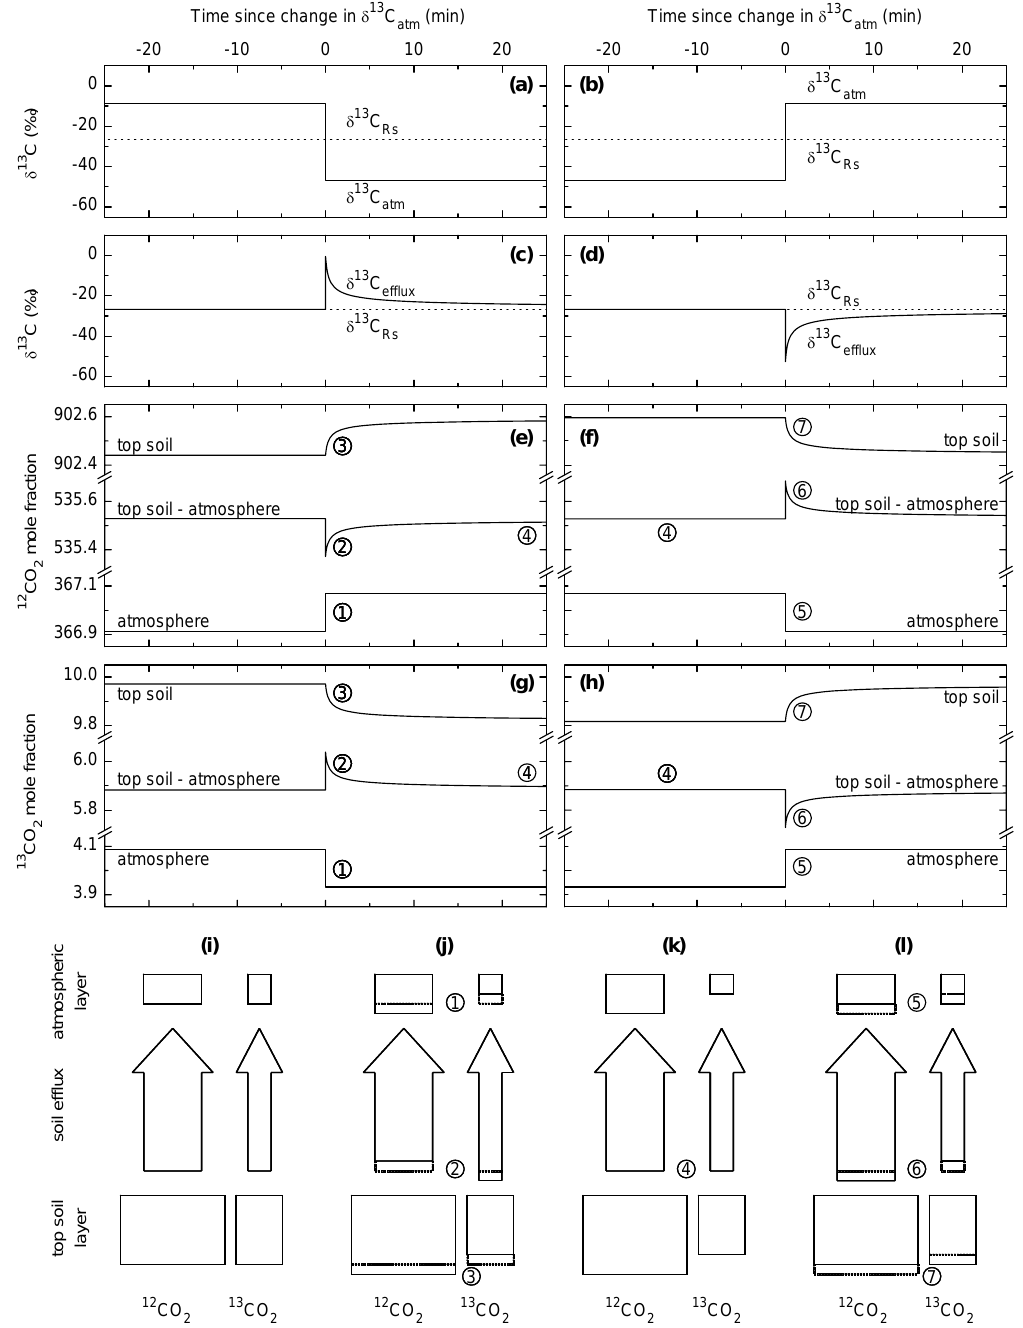
Fig. 4. Conceptual model of the influence of a step change in δ 13 C atm on δ 13 C efflux . The δ 13 C atm was switched from ambient ( − 8 . 5‰) to labelling conditions ( − 46 . 9‰) (left panels), and vice versa (right panels). (a, b) δ 13 C atm (solid line) and δ 13 C Rs (dotted line, constant). (c, d) δ 13 C efflux (solid line) and δ 13 C Rs (dotted line, constant). (e, f) 12 CO 2 and (g, h) 13 CO 2 mole fraction in the atmospheric and top soil layer, and the mole fraction difference between these two layers. Bottom (i–l) : Schematic illustration of the mechanism underlying abiotic tracer diffusion, treating 12 CO 2 and 13 CO 2 as separate gases. Squares, atmospheric and soil CO 2 pools; arrows, CO 2 fluxes; dotted lines indicate pools and fluxes prior to the changes; numbered events in the bottom scheme (i–l) match with those in the upper panels (e–h) . (i) Unlabelled system in steady-state. (j) Tracer application and associated transitions, namely (1) change in δ 13 C atm to more depleted value (corresponding to more 12 CO 2 and less 13 CO 2 ), (2) change in CO 2 diffusive fluxes due to changes in soil-atmosphere CO 2 gradient, and (3) change in soil CO 2 pool due to altered fluxes. (k) Labelled system in steady-state with (4) fluxes exhibiting the original δ 13 C. (l) Closed chamber measurement and associated transitions, namely (5) change in δ 13 C atm to ambient value, (6) change in CO 2 diffusive fluxes due to changes in soil-atmosphere CO 2 gradient, and (7) change in soil CO 2 pool due to altered